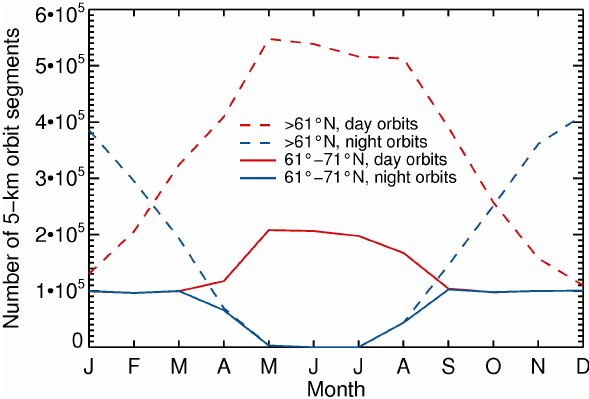
Fig. 1. Number of CALIOP 5km orbit segments as a function of month for the year 2007. Blue lines indicate nighttime retrievals, whereas red lines are for daytime. Solid lines correspond to the lat- itude interval 61 ◦ − 71 ◦ N and dashed lines are for the region pole- ward of 61 ◦